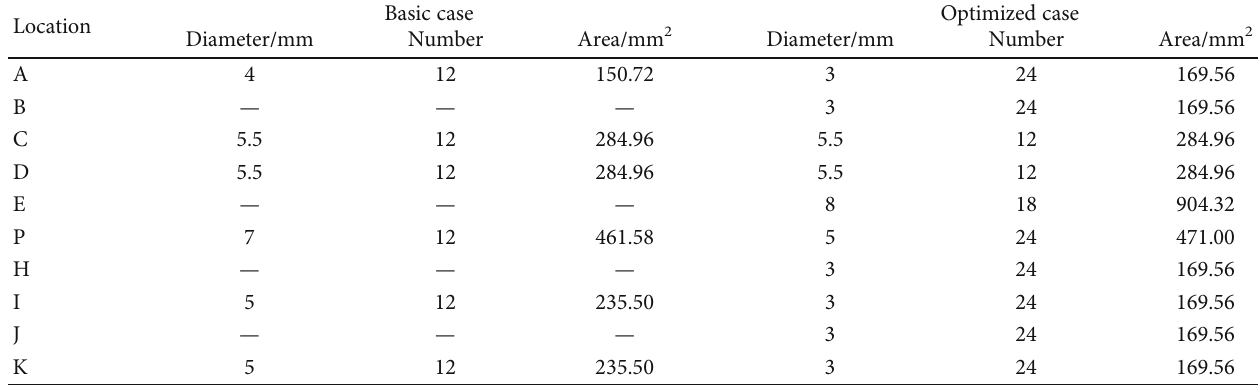
Table 1: Liner hole speci fi cation comparison between the basic case and optimized case.